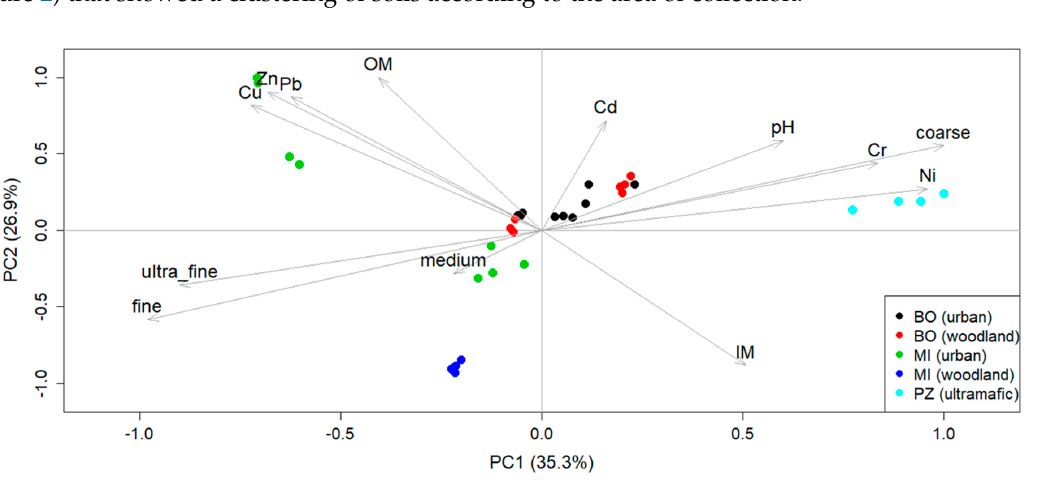
Figure 2. Soil clustering after principal component analysis (PCA). The input data were the soil variables of granulometry, OM, IM, and total heavy metals concentration.